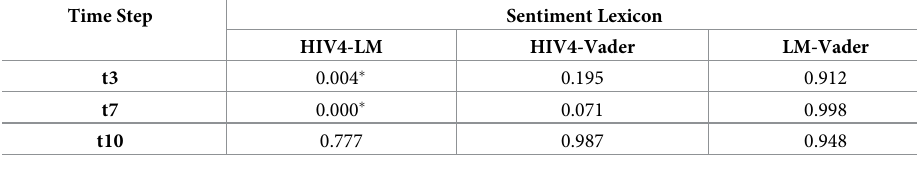
Table 7. p-values for the second hypothesis